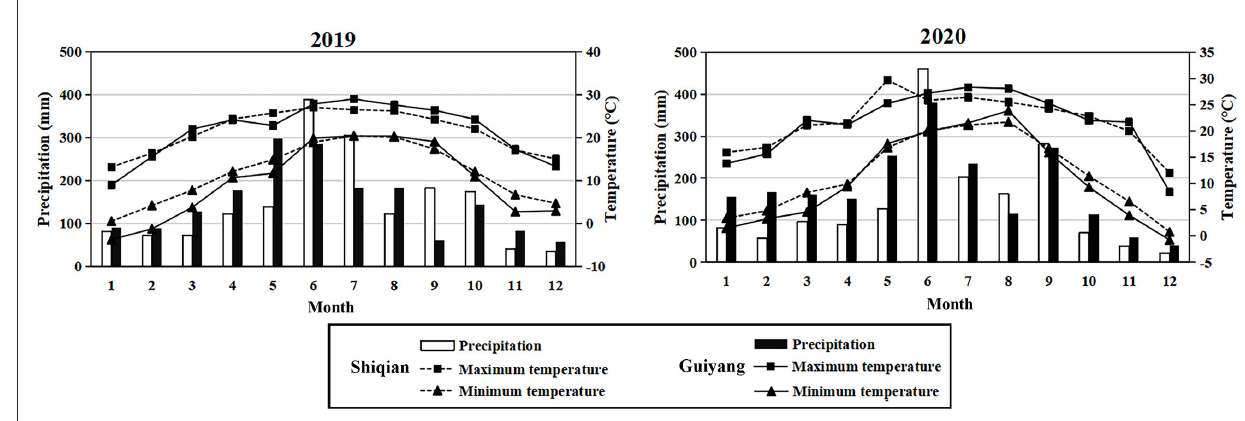
FIGURE1 Monthly rainfall, minimum temperature, and maximum temperature in the study areas in 2019 and 2020.